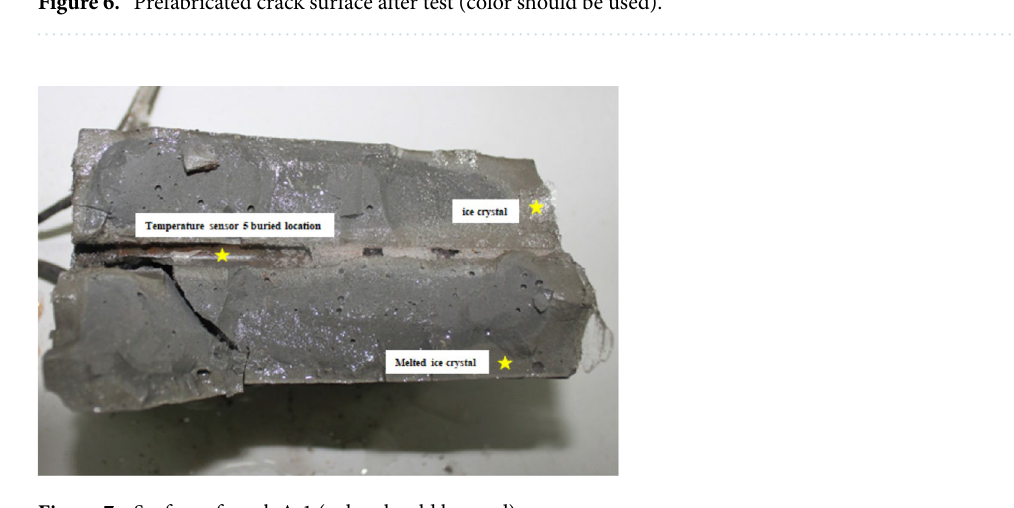
Figure 7. Surface of crack A-1 (color should be